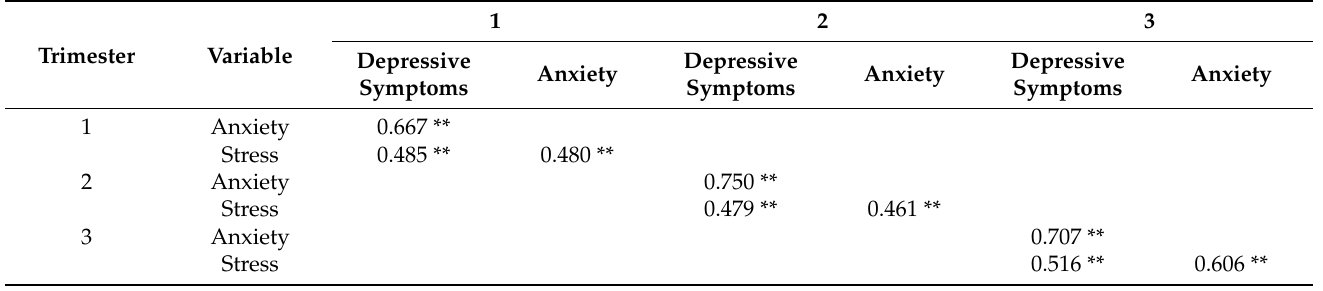
Table 2. Correlation between depressive symptoms, anxiety, and pregnancy stress in each trimester ( n = 136).